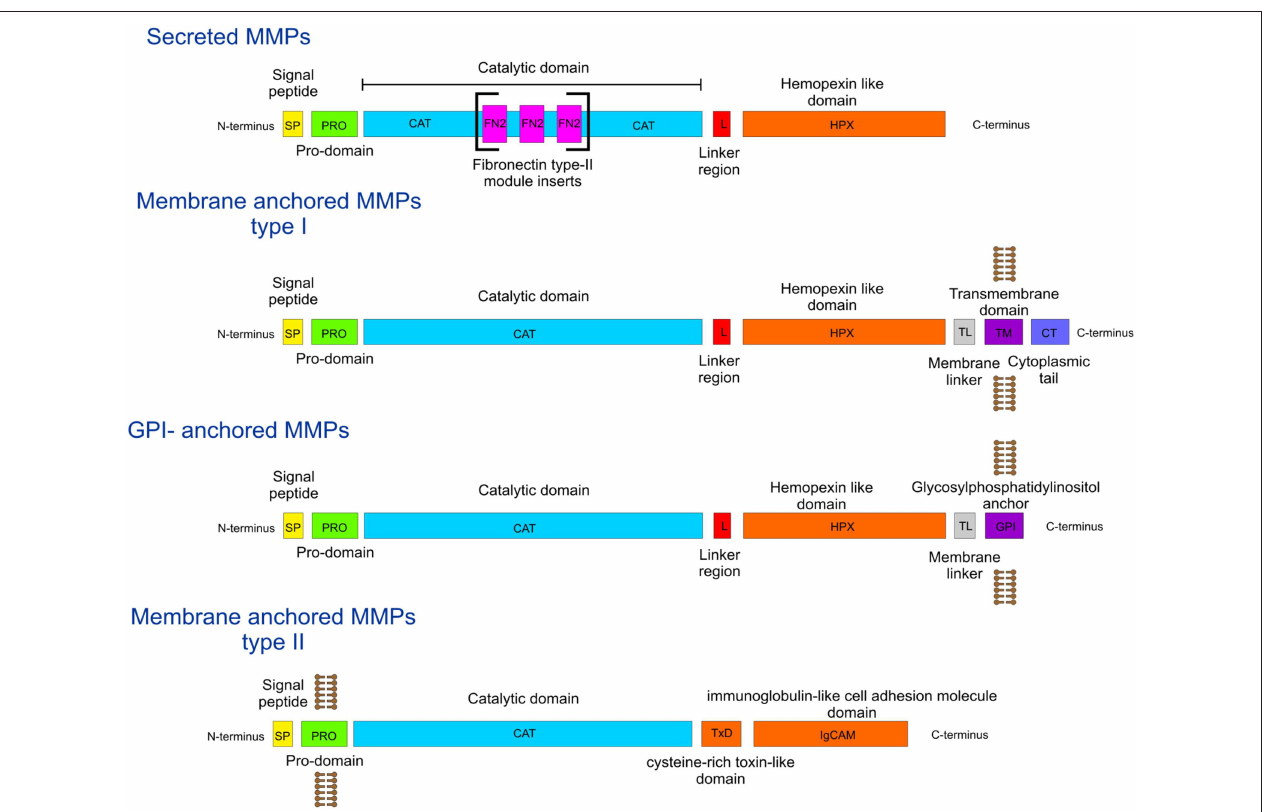
FIGURE 1 | Diagrammatic representation of MMP domain